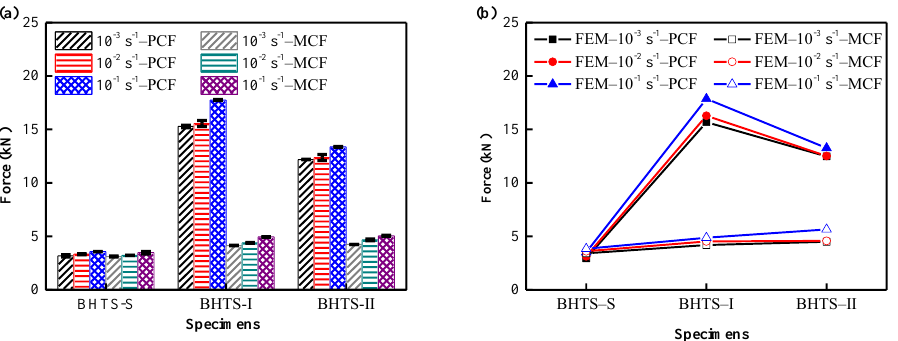
Figure 13. Comparison of PCF and MCF average values of experiment and FEM: ( a ) experiment; ( b ) FEM.